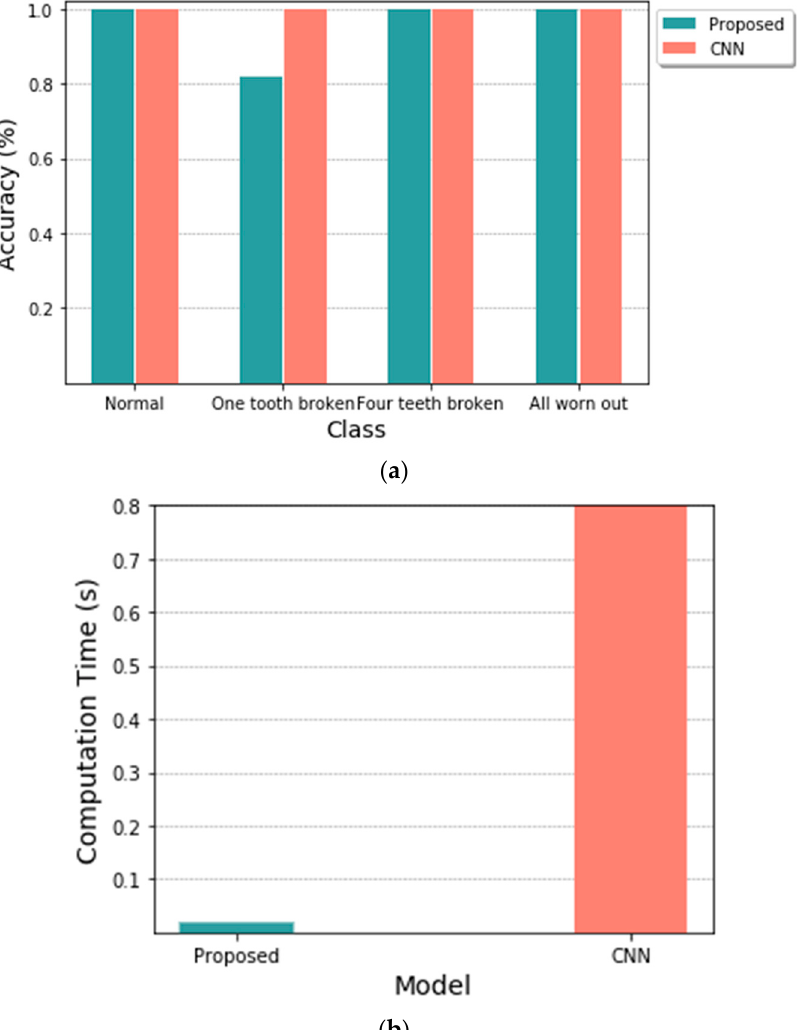
Figure 12. Comparison of proposed DNN model and CNN model: ( a ) accuracy in test dataset; ( b ) computation time per